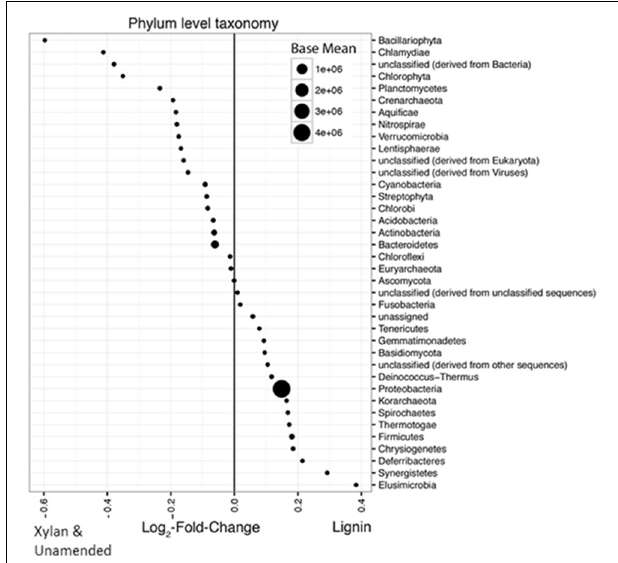
FIGURE 6 | Average log 2 -fold changes of phyla between lignin-adapted consortia and the controls (xylan-adapted and unamended consortia). Abundances from the MG-RAST annotation were compared between the two lignin-adapted consortia and the four non-lignin controls. The first and second incubations were combined for each substrate. The non-lignin controls included both the unamended control and the xylan-adapted consortia. The size of the point indicates its normalized relative abundance. A positive log 2 -fold change indicates higher abundance in lignin-adapted consortia while a negative log 2 -fold change indicates higher abundance in the controls. Base mean is the average of the normalized counts over all samples. Phyla that were less than 0.005% were excluded.